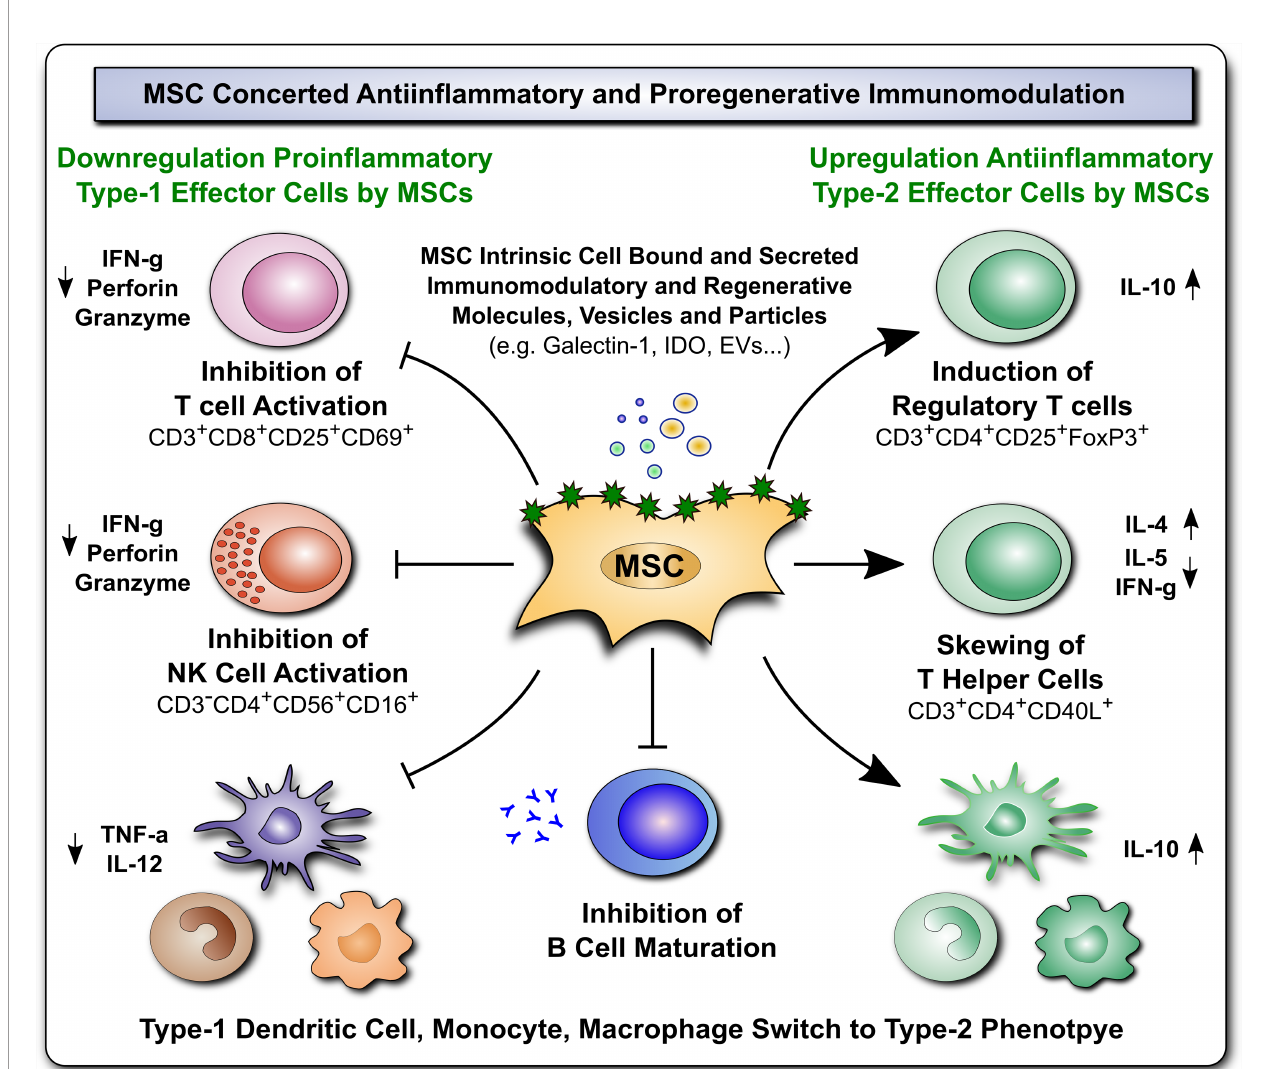
FIGURE 2 | Immunomodulatory and Regenerative Properties of MSCs. Mesenchymal stromal cells (MSCs) employ a broad array of antiin fl ammatory and proregenerative immunomodulatory mechanisms, which are exerted either by MSCs directly, through intrinsic cell associated/bound, or secreted immunomodulatory and regenerative molecules, vesicles/particles (e.g. Galectin-1, indoleamine-2,3-dioxygenase (IDO), and extracellular vesicles, (EVs), respectively), or alternatively indirectly through MSCmediated favorable polarization of innate and adaptive immune responses (e.g. downregulation of proin fl ammatory type-1 effector cells, such as inhibition of T and NK cell activation, and upregulation of antiin fl ammatory type 2 effector cells, such as induction of regulatory T cells, skewing of T helper cells, and switch in type 1 dendritic cell, monocyte, and macrophage phages to type 2 phenotype, and inhibition of B cell maturation), that both lead to favorable changes in the predominant cytokine milieu (e.g. downregulation of proin fl ammatory mediators TNF-a, IFN-g, perforin and granzyme, but induction of antiin fl ammatory IL-10, in conjunction with secretion of multiple trophic and regenerative factors, not shown here) that altogether mediate bene fi cial tissue repair and proregenerative